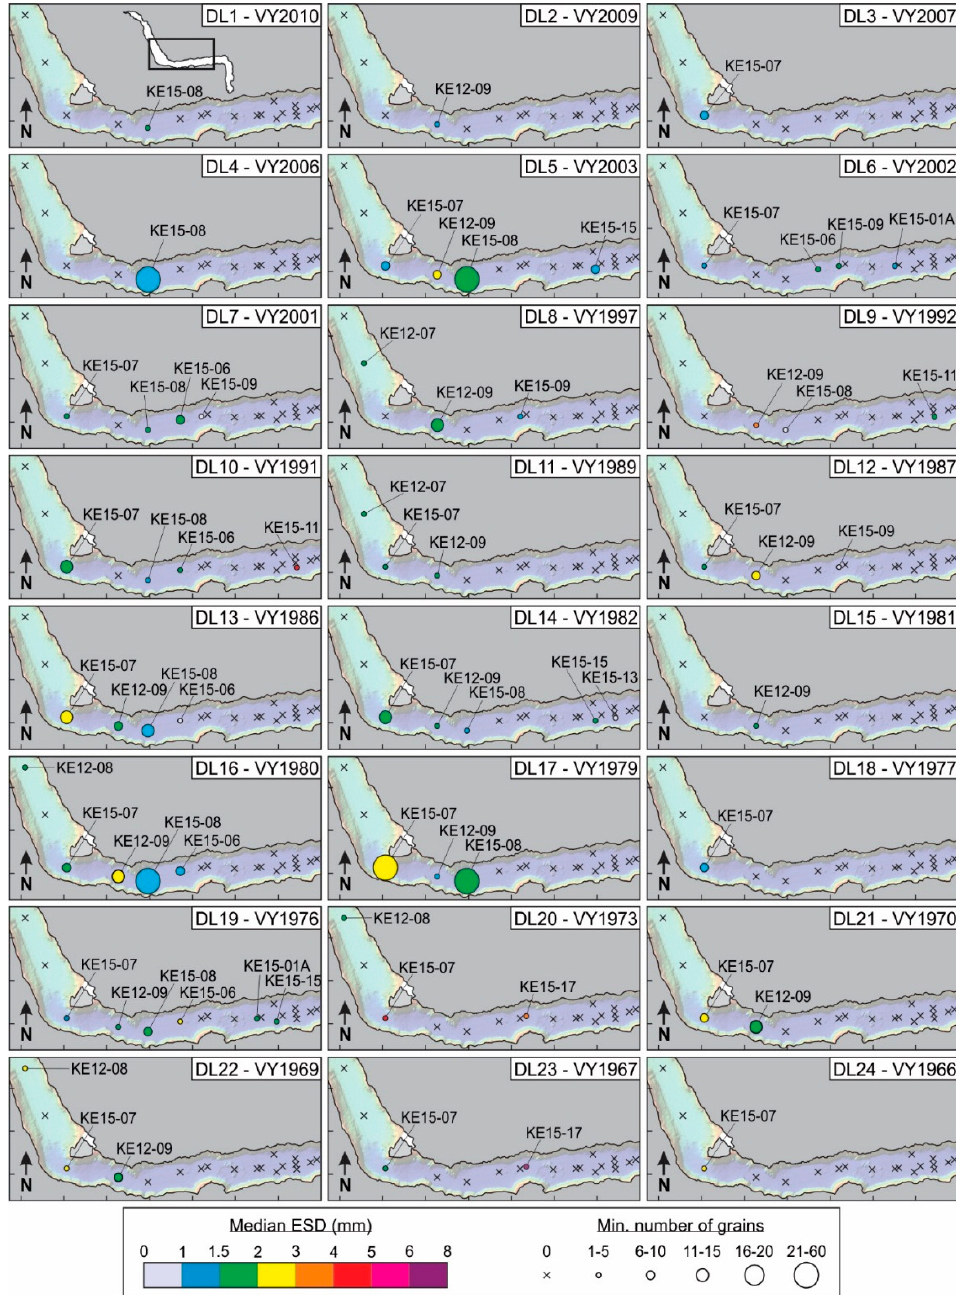
Figure 6. Overview of the 24 debris laminae (DL) located in different cores of Kenai Lake. The cores that contain a certain debris lamina are plotted together with the minimum number of grains found in the lamina and their median equivalent spherical diameter (EDS).